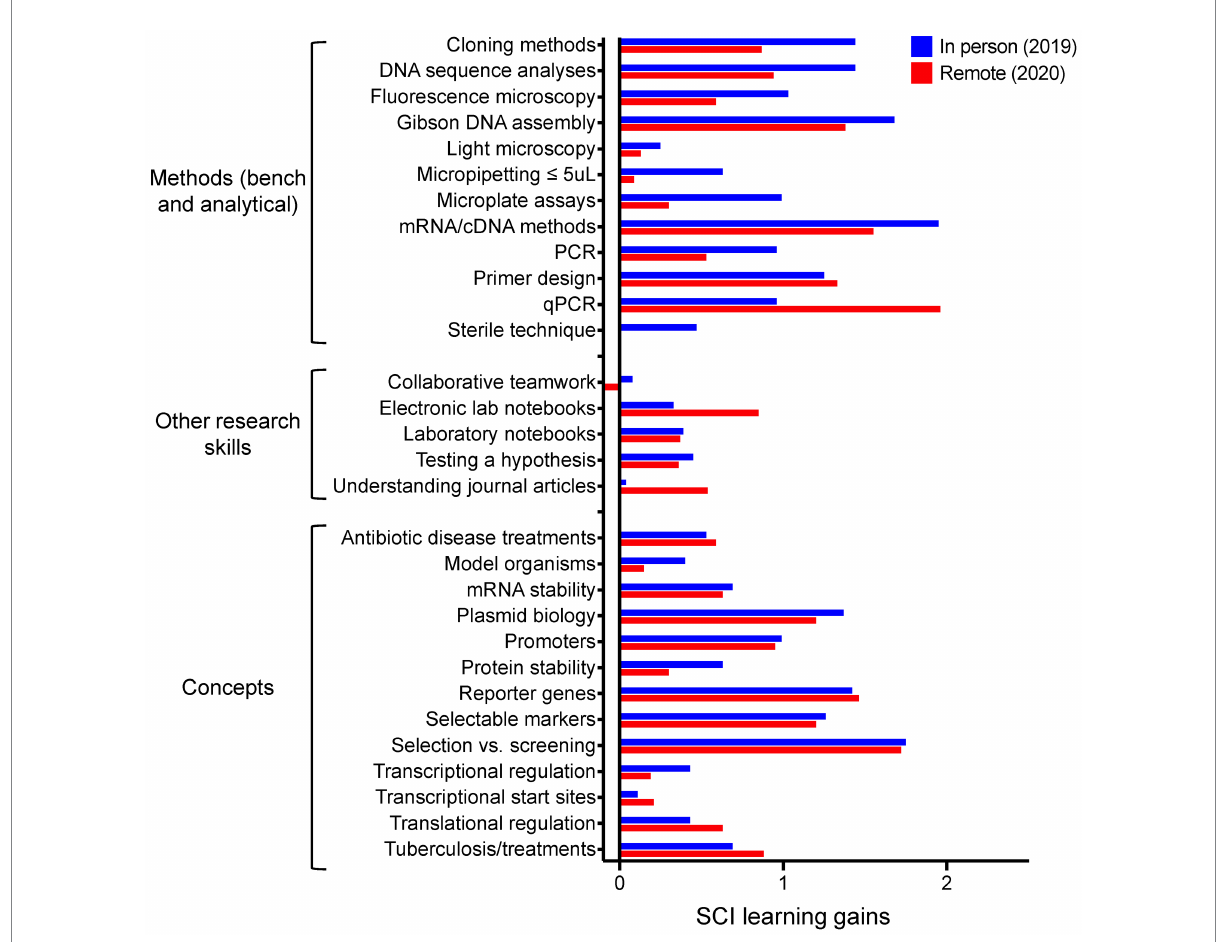
FIGURE 3 SCI learning gains, comapring in-person ( n = 16 student responses) vs. entirely remote ( n = 17) delivery for the MBGE